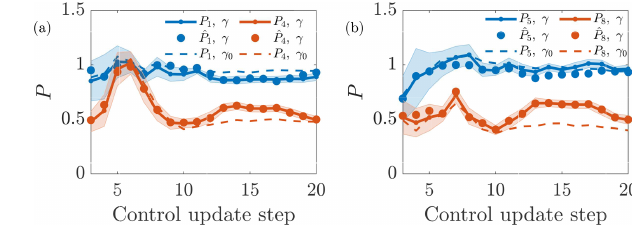
Figure 7. Yaw misalignment for turbine 1 (a) applied and (b) re- alized for the deterministic optimization methodology with filtered (Case D) and predictive forecast (Case D–F) wind-direction-based yaw optimization.